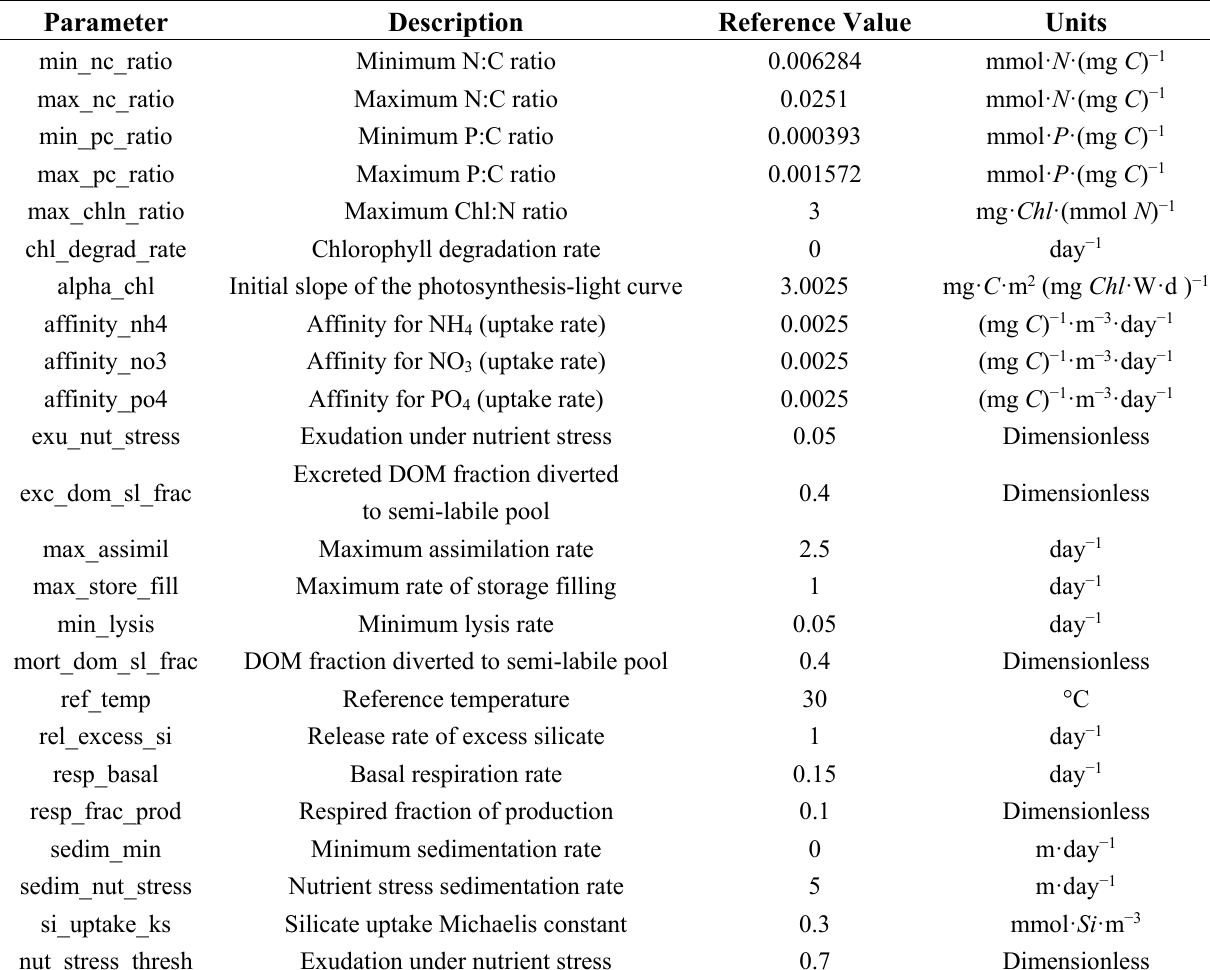
Table 2. List of parameters for Producers (diatoms).